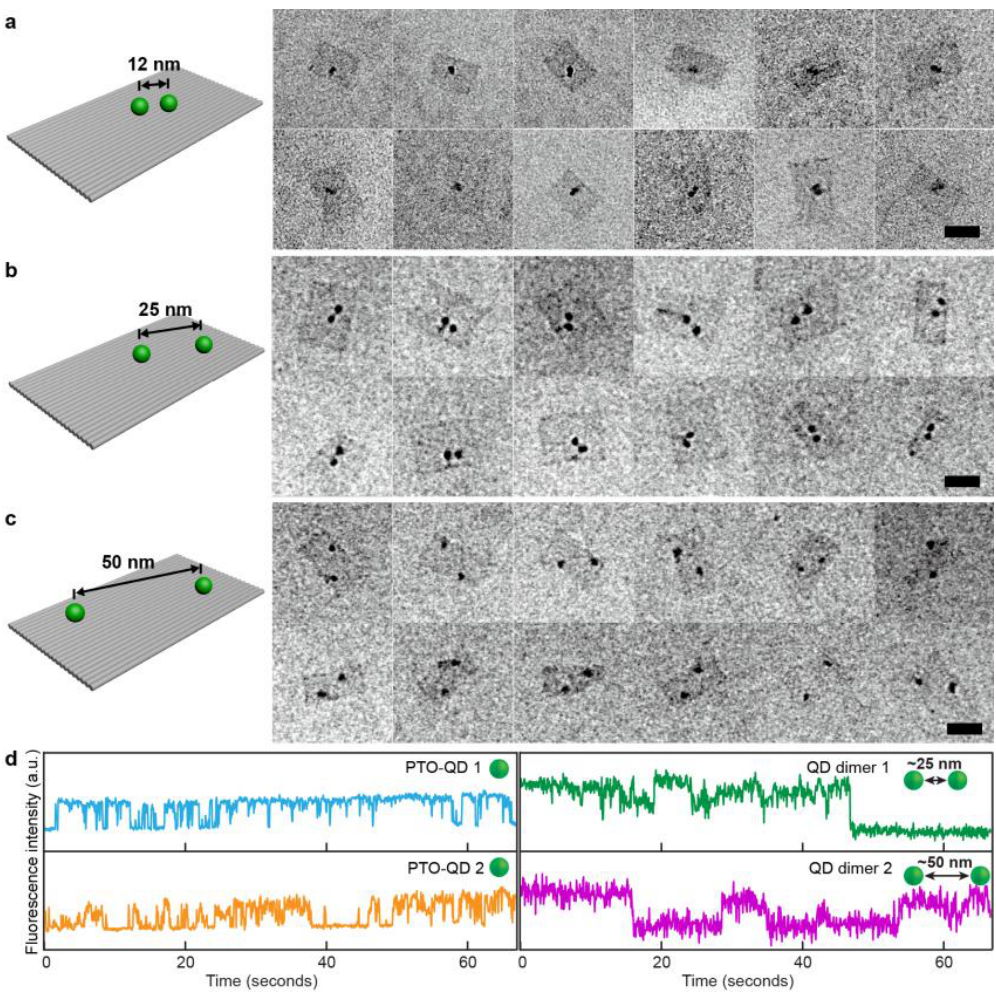
Figure 3. Assembly scheme and corresponding transmission electron microscopy images of CdSe/CdS/ZnS quantum dots assembled into dimers with different distances on one-layer rectangular DNA origami templates. ( a ) QD dimer with 12 nm inter-particle spacing; ( b ) 25 nm inter-particle spacing; ( c ) 50 nm inter-particle spacing. Scale bars: 50 nm; ( d ) Fluorescence intensity traces of various QD samples: individual PTO-DNA modified QDs (blue and orange), QD dimers with 25 nm (green) and 50 nm (purple) spacings.